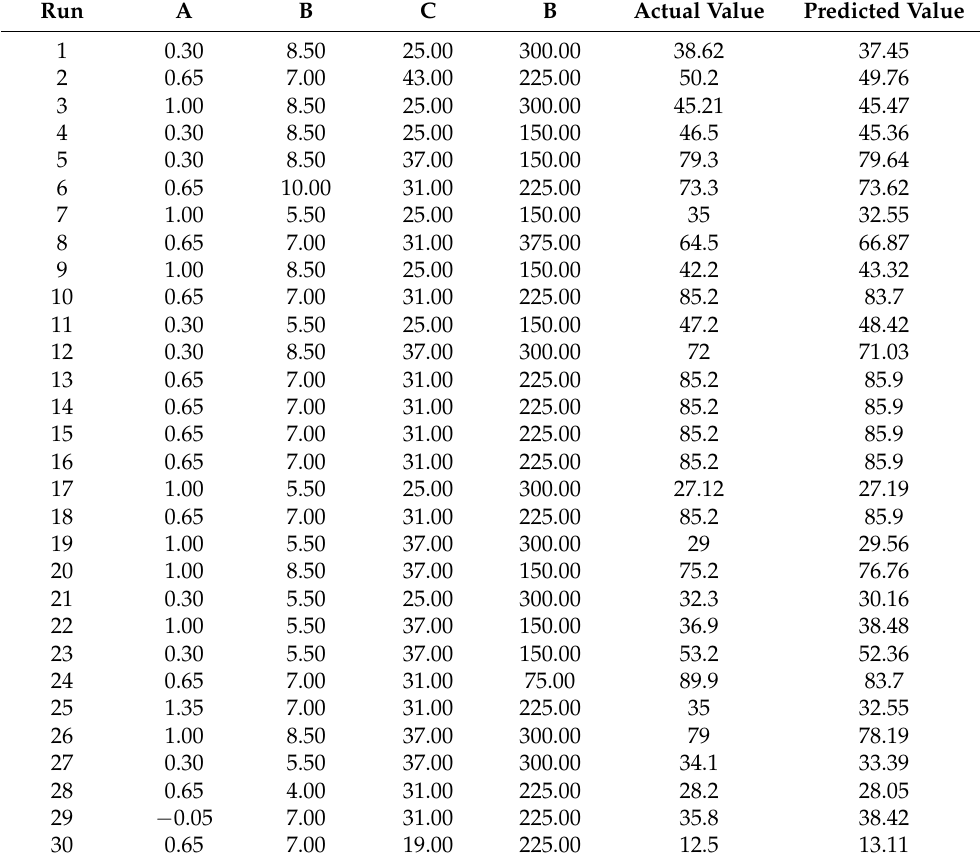
Table 10. Experimental design and results of central composite design on Reactive Red 120 decolouri- sation by consortium JR3.